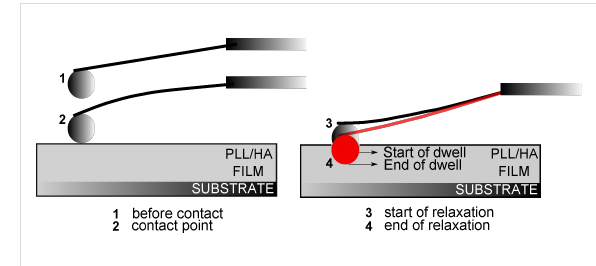
Figure 8: A summary of the stress-relaxation measurements. “Start of dwell” is the indentation depth at which the driving of the z -piezo is stopped. “End of dwell” shows the maximum indentation depth caused by the relaxation on the